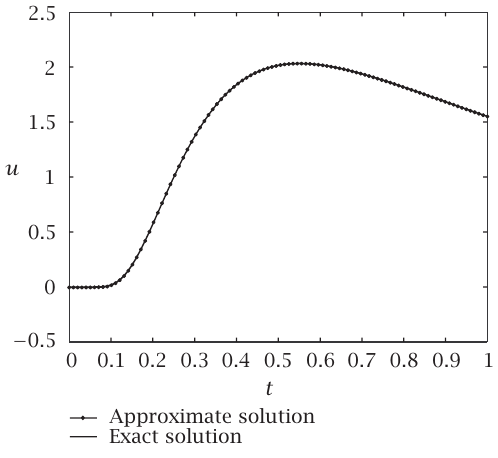
. = 0 . 002, E = (cid:5) f (cid:5)